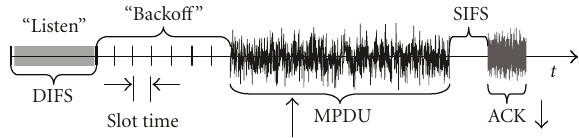
Figure 1: Transmission of MPDU and ACK